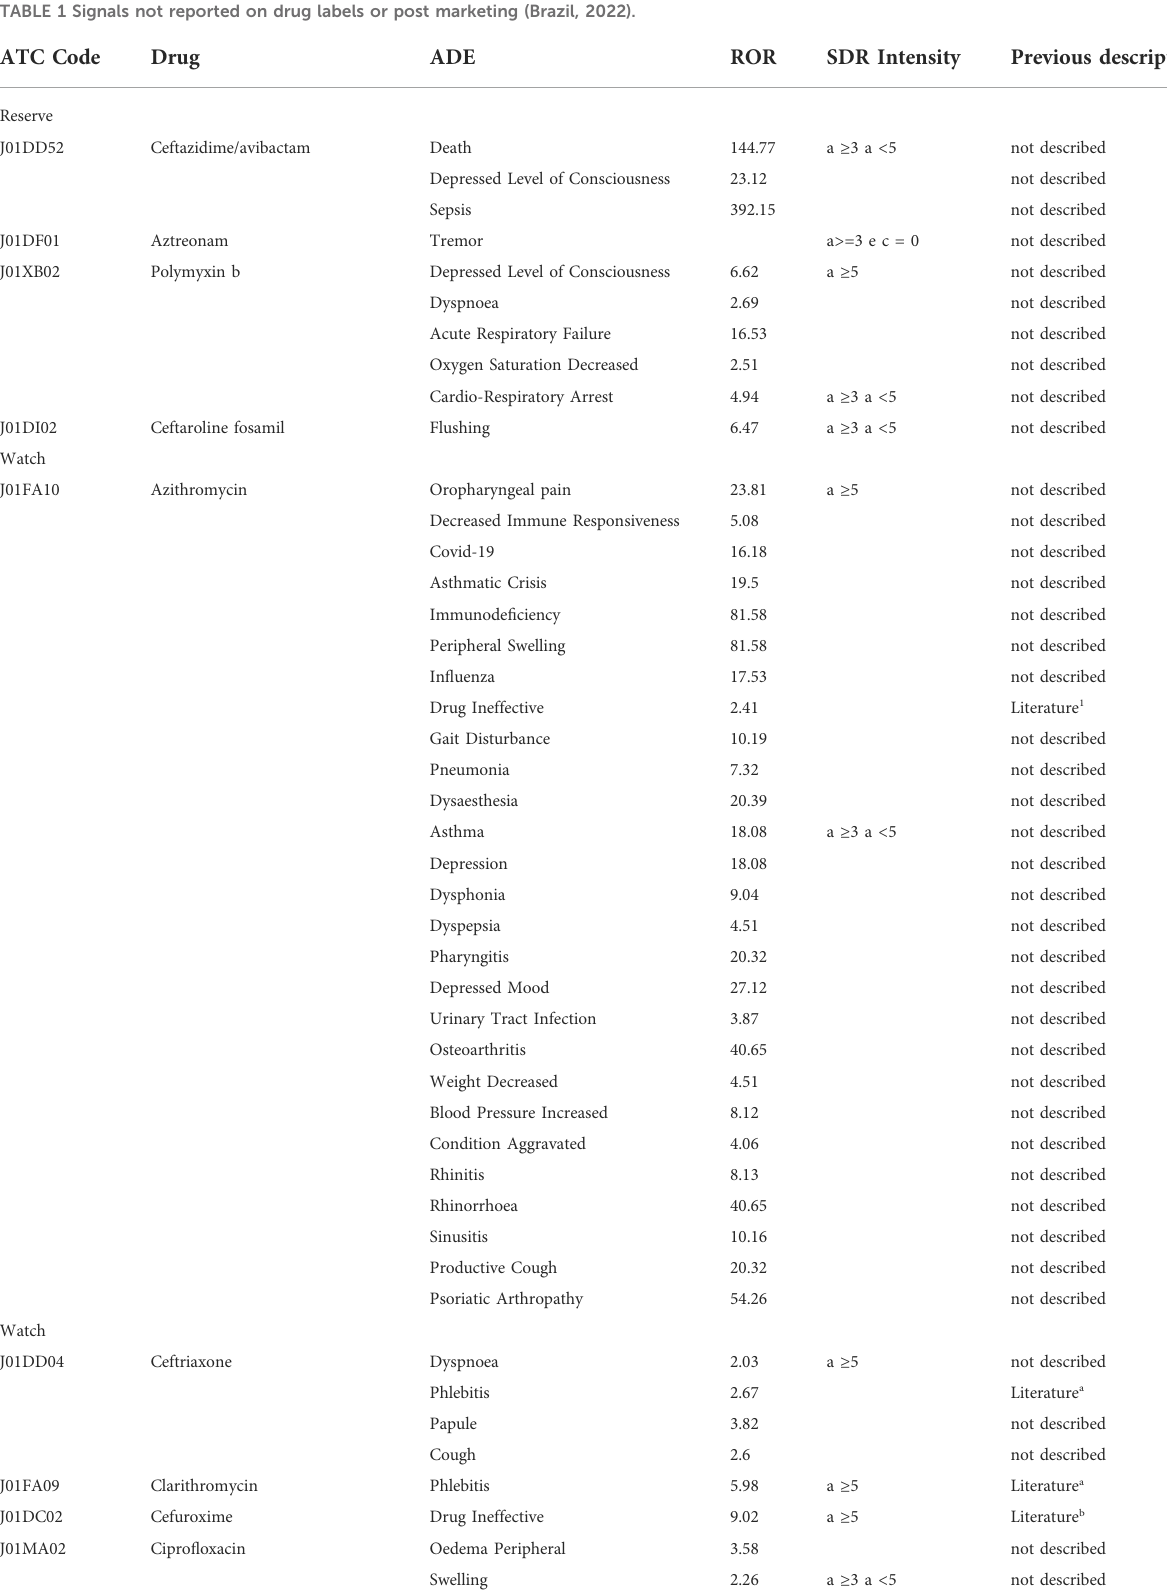
TABLE 1 Signals not reported on drug labels or post marketing (Brazil, 2022). ATC Code